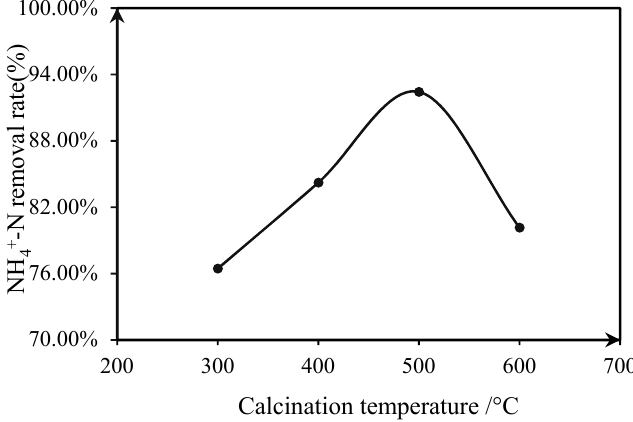
Figure 5. The effect of calcination temperature.